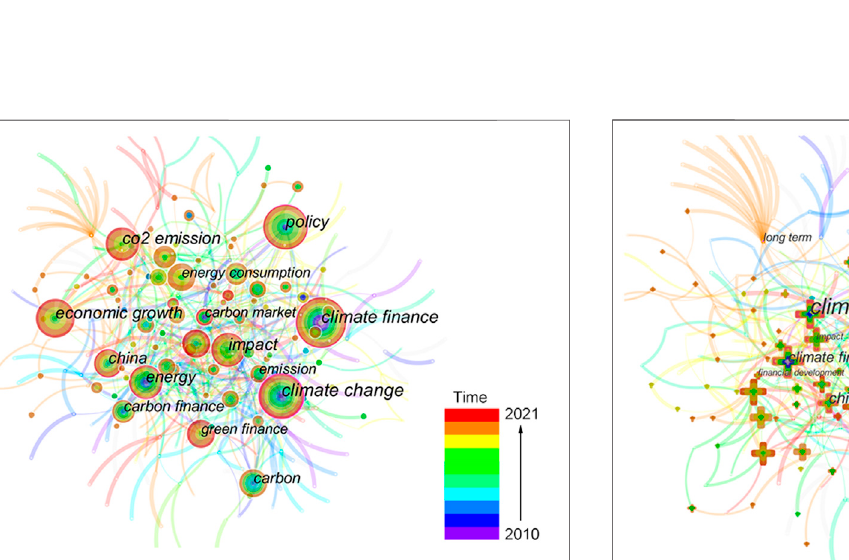
Frontiers in Environmental Science |